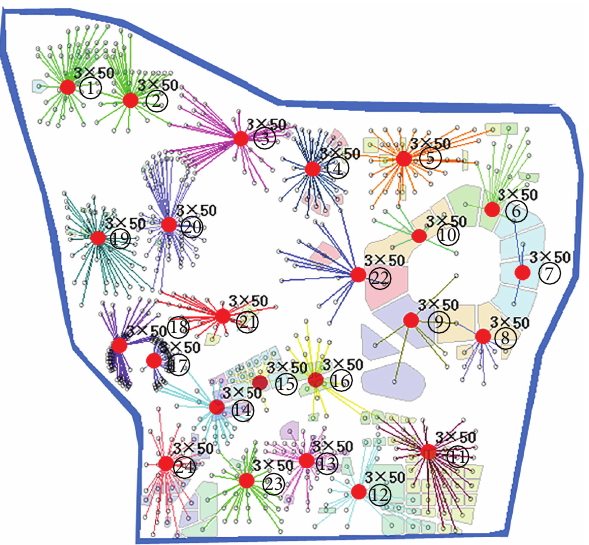
Figure 6: Planning result by the original WVD.